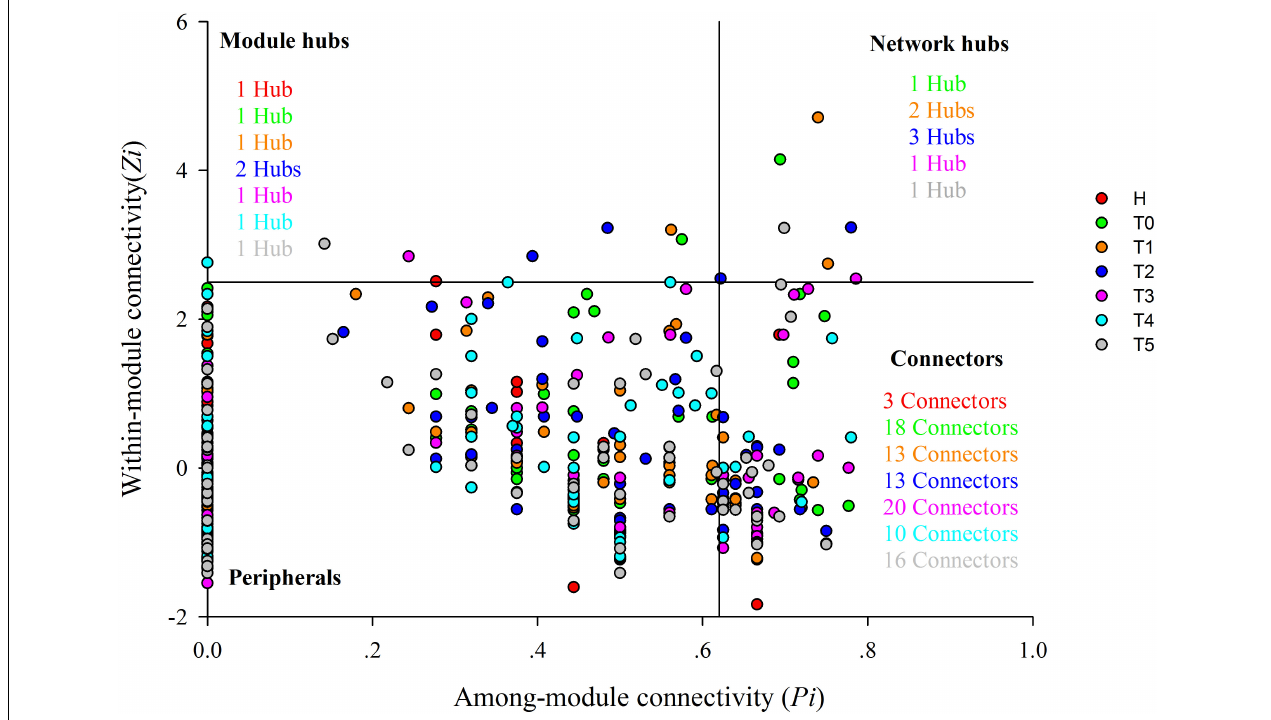
FIGURE 2 | Z-P plot showing the classification of nodes to identify putative keystone species in healthy individuals and colorectal cancer patients in response to chemotherapy. Each symbol represents an OTU. Different colors represent different groups, namely, red for healthy individuals (H), green for CRC patients before the first treatment (T0), orange for CRC patients before the second treatment (T1), blue for CRC patients before the third treatment (T2), pink for CRC patients before the fourth treatment (T3), water blue for CRC patients before the fifth treatment (T4), and gray for CRC patients before the sixth treatment (T5). Module hubs have the nodes with Pi ≤ 0.62 and Zi > 2.5, connectors with Pi > 0.62 and Zi ≤ 2.5, and network hubs with Pi > 0.62 and Zi > 2.5, peripheral nodes with Pi ≤ 0.62 and Zi ≤ 2.5. There are 1, 1, 1, 2, 1, 1, and 1 module hub in H, T0, T1, T2, T3, T4, and T5, respectively. There are 1, 2, 3, 1, and 1 network hub in T0, T1, T2, T3, and T5, respectively. There are 3, 18, 13, 13, 20, 10, and 16 connectors in H, T0, T1, T2, T3, T4, and T5,